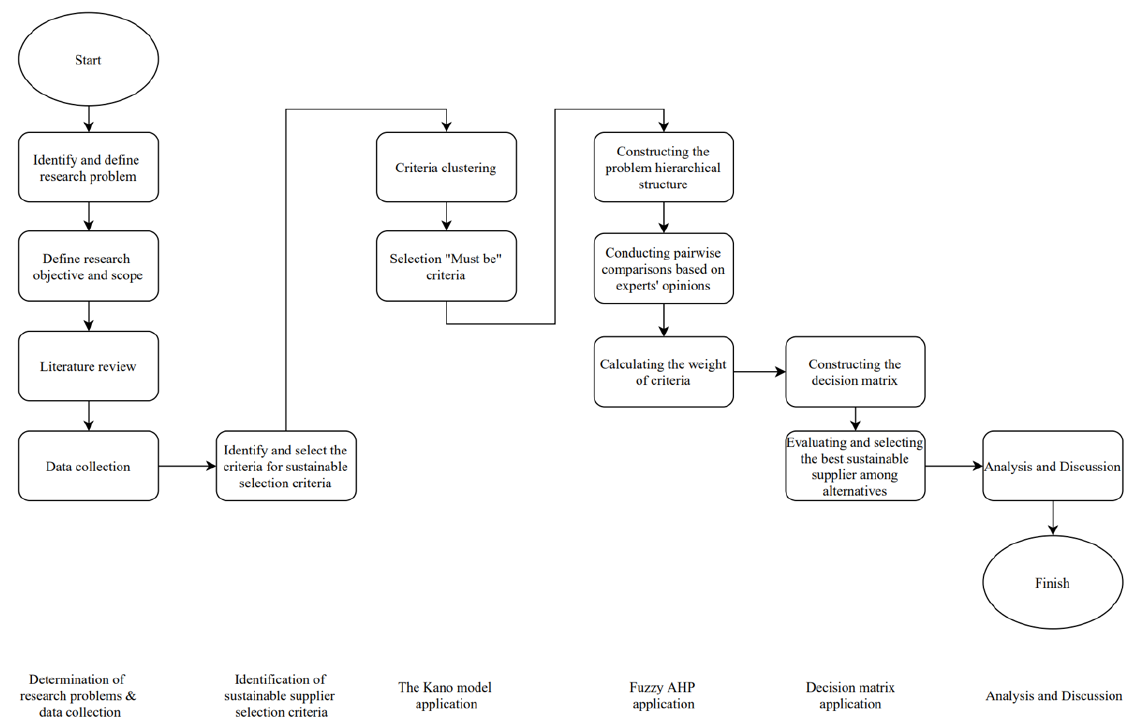
Figure 1. Research design.